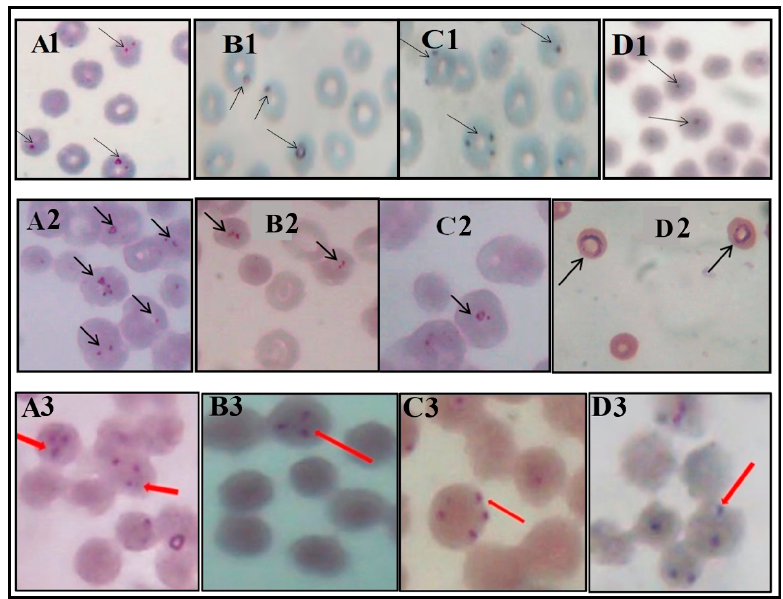
Figure 1. Blood stages of intra-erythrocytic parasites/organisms seen in thin blood films of cattle, dog and human samples. Arrows point to intra-erythrocytic parasites/organisms. A1 – D1 shows slides from cattle blood samples with different configurations of parasites/organisms. A2 – D2 shows slide from dog blood samples, where A2 – C2 are fields from two samples that did not have DNA amplification, using the B. canis primers. A2 and C2 are different fields of the same slide, and D2 is a field from the sample that was PCR-amplified with the B. canis primers. A3 – D3 displays slides from the human blood sample, where Slides A3 and B3 show “triad” configuration, C3 shows “tetrad” configuration, and D3 shows “paired” configuration.